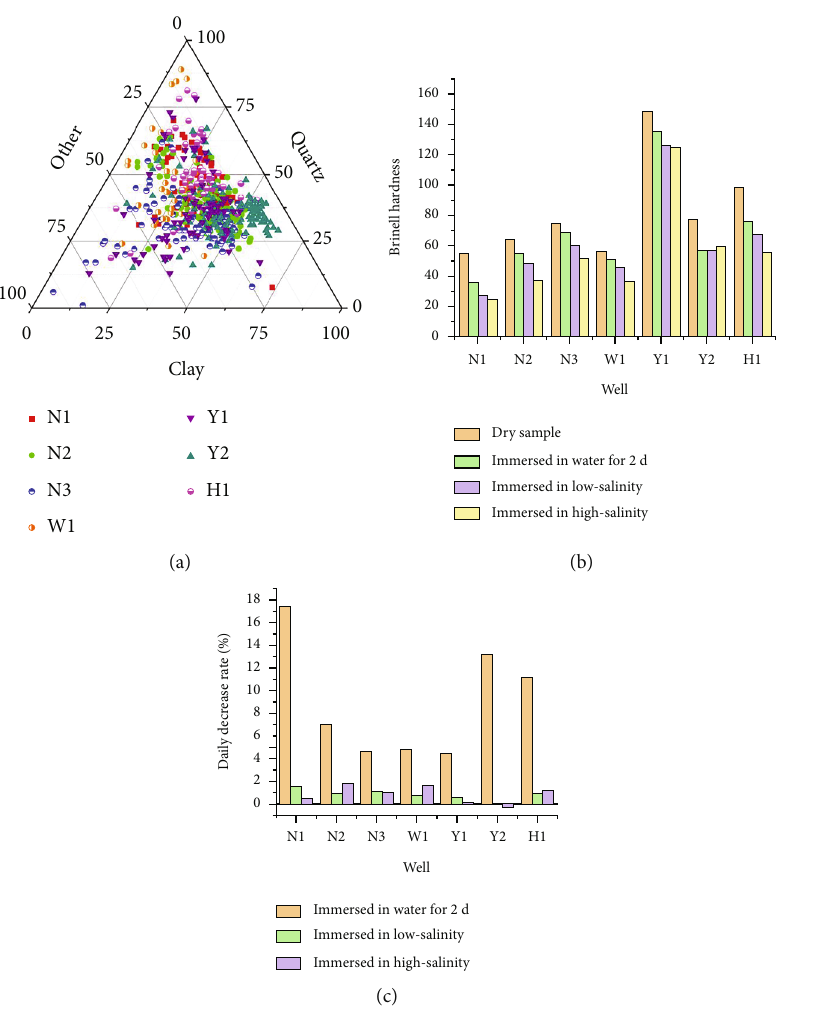
Figure 6: Analysis of shale softening mechanism. (a) Mineral content distribution of wells. (b) Brinell hardness change after shale is immersed in liquids. (c) Daily decrease rate of Brinell hardness of shale immersed in di ff erent